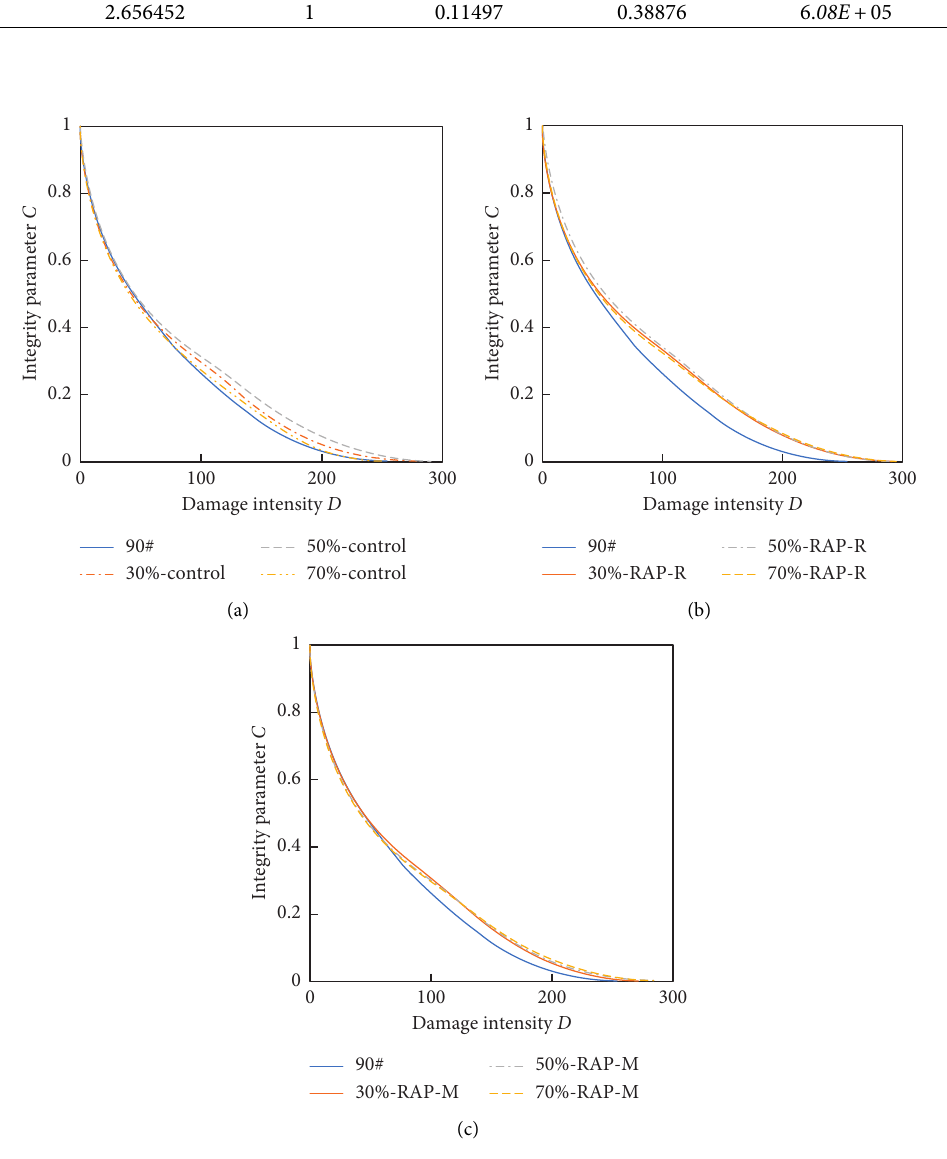
Figure 27: Typical damage plots for various recycled binders. (a) Control binder; (b) RAP-R binder; and (c) RAP-M binder.